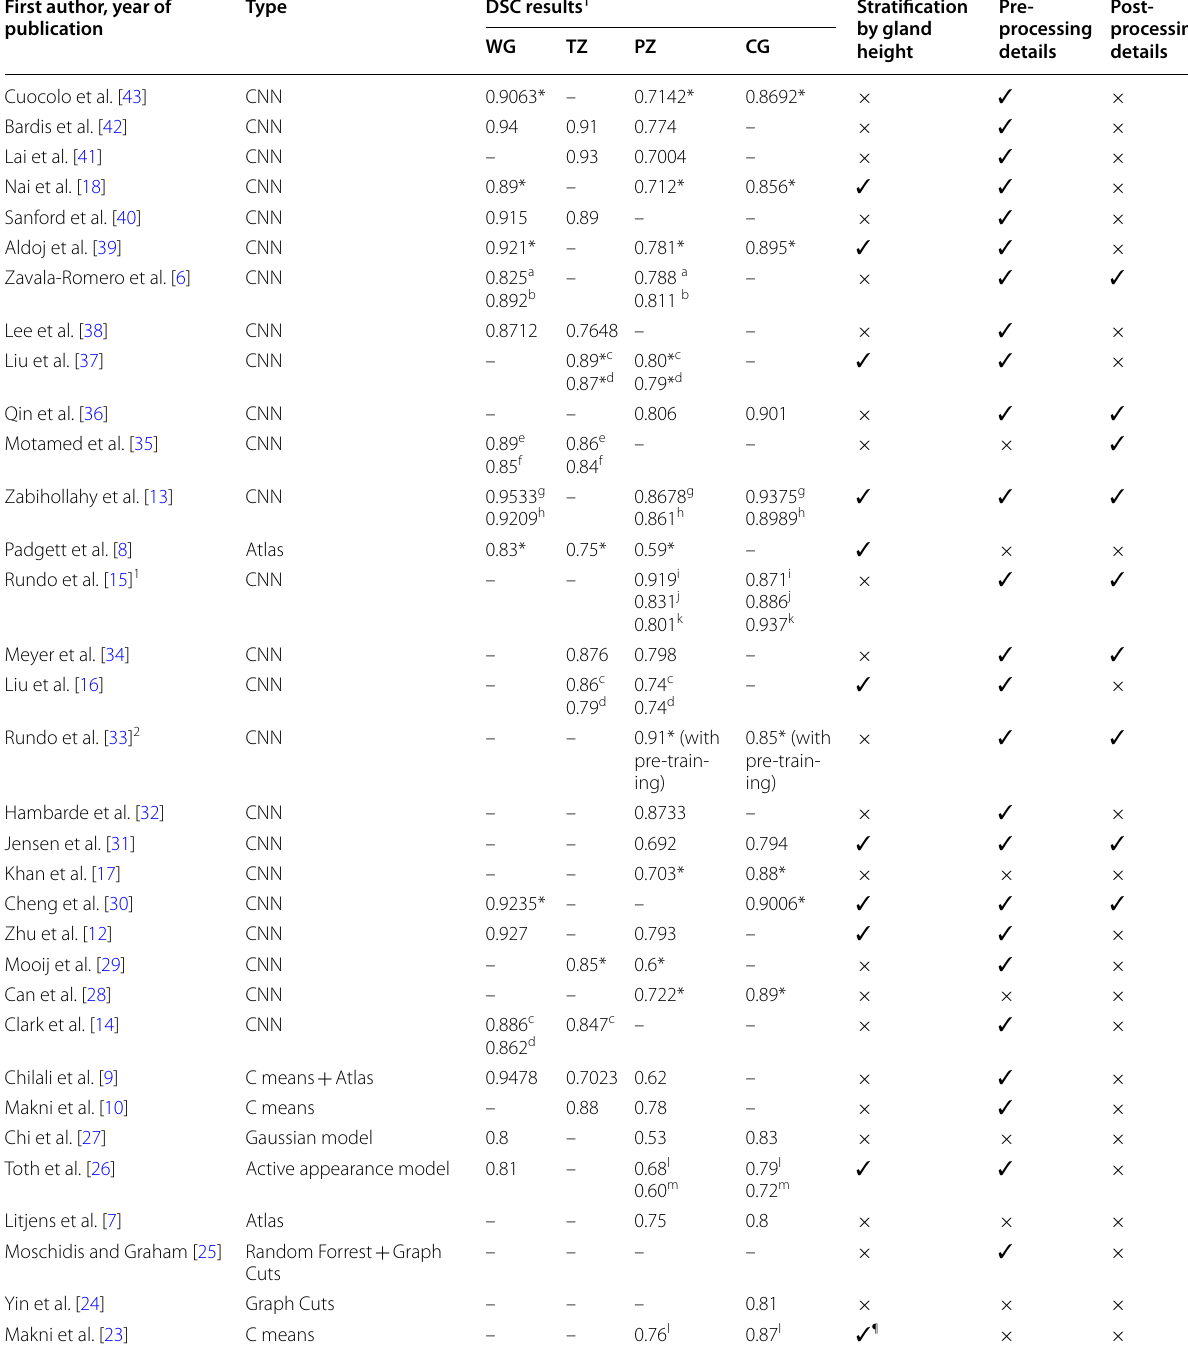
Table 5 Overview of segmentation methods with performance based on DSC. Number of articles reporting stratification by gland height, and reporting pre‑ or post‑processing